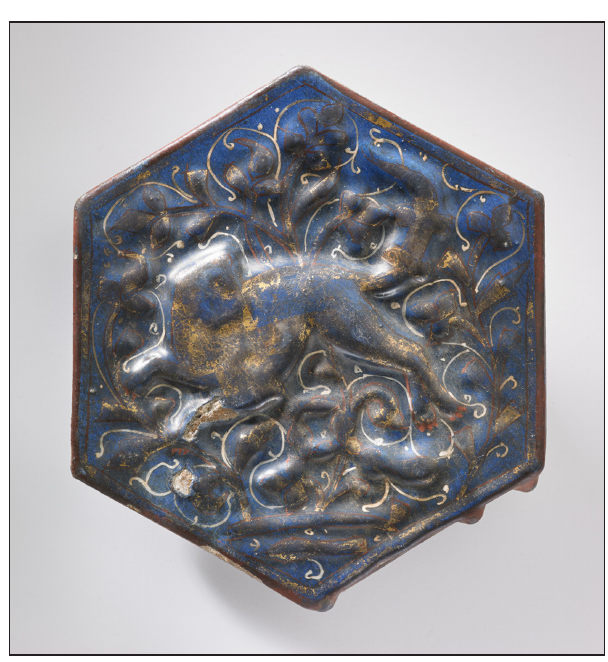
Fig. 17 : Hexagonal tile, fritware with moulded, overglazed, and gilded decoration, Iran (Takht-i Sulaiman), c . 1275. C927A136X, given by Miss E. G. Tanner in 1920. © Holburne Museum, Bath. Photo: